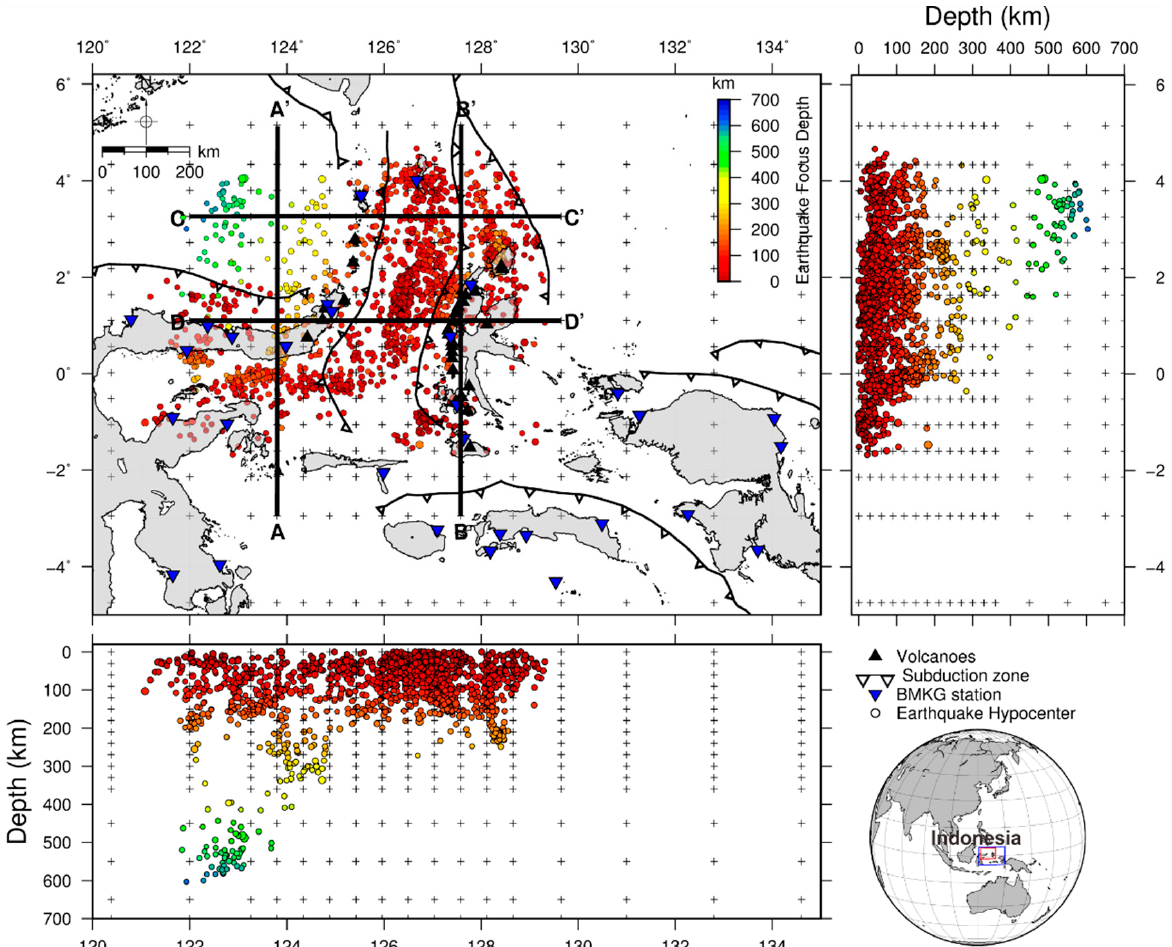
Figure 4. The horizontal and vertical seismic map of the research location in the Molucca Collision Zone. The bold black lines A-A ′ (south–north), B-B ′ (south–north), C-C ′ (west–east), D-D ′ (west–east) denote the areas of the vertical cross-section tomography. The black plus sign represents the distribution of the grid nodes for tomographic inversion; the colored dots indicate the distribution of earthquakes; the blue triangles are BMKG stations, and the black triangles signify volcanoes.